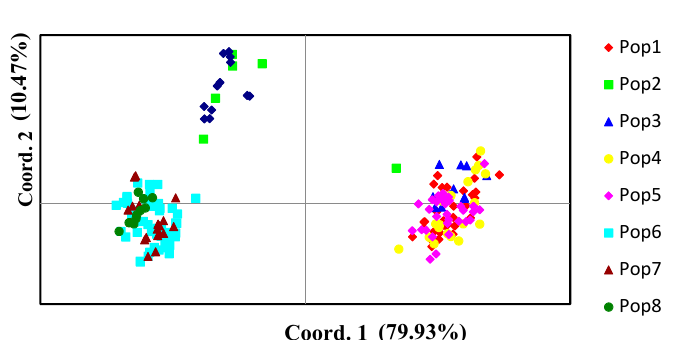
Figure 5. Principal coordinate analysis (PCoA) of the microsatellite diversity among the 193 accessions